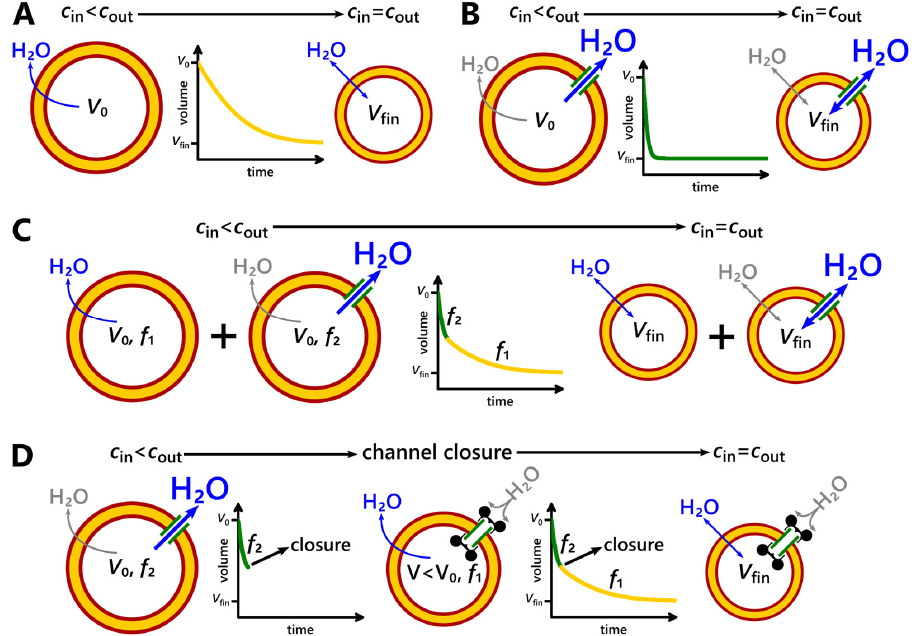
Figure 2. Scheme of vesicular volume changes accessible in a liposome ensemble. Possible water pathways and the composition of the vesicle ensembles differ between the panels. Generally, a population of vesicles with the initial volume V 0 and internal osmolarity c in (leftmost vesicles in each panel) is exposed to hyperosmotic conditions by rapidly increasing external osmolarity c out . The resulting net efflux of water through the available water-conducting pathways (illustrated by unidirectional blue or gray arrows) leads to osmotic equilibrium when c in = c out (illustrated by bidirectional blue or gray arrows) and V 0 has decreased to V fin = V 0 × c 0 / c out , where c 0 is the initial intravesicular osmolarity (rightmost vesicles in each panel). Vesicle volume decreases as c in approaches c out . ( A ) In a homogeneous population of lipid-only vesicles, the lipid bilayer is the only pathway for water conduction, and vesicle volume (yellow curve) decreases with permeability P f,l corresponding to that of the bare lipid bilayer. ( B ) In a homogeneous population where each vesicle contains n water-conducting channels with a unitary water permeability p f far exceeding P f,l × A v , where A v is vesicle surface area, the rate of osmotically-driven shrinkage is dominated by water conduction through the channels (green curve). Thus, the total channel permeability P f,c = n × p f / A v effectively determines the deflation rate. Importantly, there is only a single measurable deflation rate since the vesicle population is homogeneous. ( C ) Given an inhomogeneous vesicle ensemble where 50% are bare lipid vesicles ( f 1 ) and 50% are proteoliposomes containing a single rapidly water-conducting channel ( f 2 ), two different shrinking kinetics are observable. The fast component is dominated by the highly-permeable proteoliposomes ( f 2 , green curve), which achieve osmotic equilibrium much faster than the bare lipid vesicles ( f 1 , yellow curve). ( D ) Given a homogeneous ensemble of channel-containing vesicles that nonetheless results in two distinct shrinking kinetics, two interpretations are possible: (i) The channels first facilitate water transport but experience a sudden block (indicated by the Mickey Mouse ears) before vesicle deflation is completed. Consequently, the initial rapid rate of vesicle volume change ( f 2 ) is followed by the rate of non-facilitated water permeation across the bare lipid bilayer ( f 1 ). This scenario appears to reflect the mechanism of water conduction by supramolecular channels that would justify the data treatment performed by Itoh et al. [10] (ii) The fast kinetic has nothing to do with vesicle deflation but indicates some unrelated process (e.g., particle aggregation).